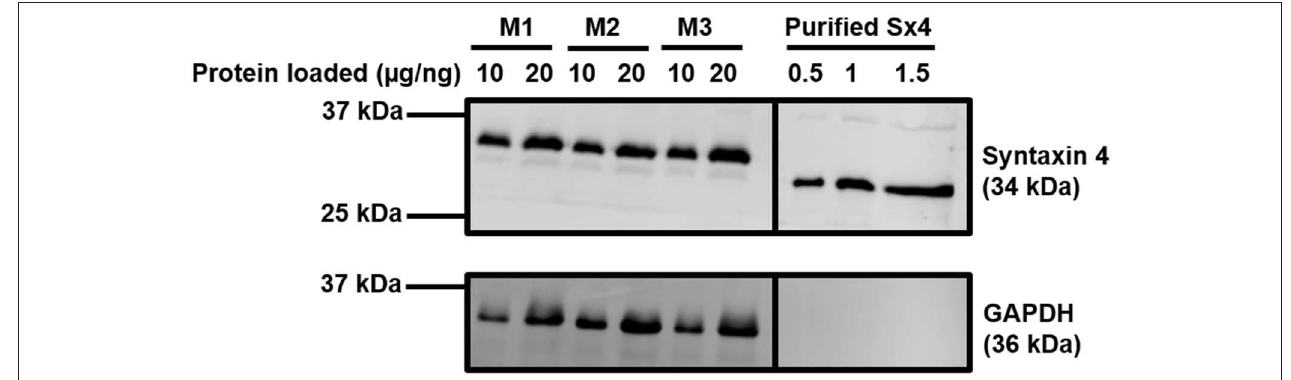
FIGURE 1 | Quantification of Syntaxin 4 expression in the heart. Protein lysates were generated from 20-week old male mouse cardiac tissue and subjected to SDS-PAGE and immunoblotting alongside purified recombinant Sx4. Lysates were incubated with antibodies probing for the expression of Syntaxin 4 and GAPDH (loading control) as shown. Protein loaded refers to 10 or 20 µ g of protein for the M1-M3 mouse cardiomyocyte samples or 0.5–1.5 ng of purified Syntaxin 4 protein (lacking the transmembrane domain and thus migrating faster than endogenous, full length Syntaxin4), as indicated. M1-3 indicates biologically independent mouse cardiac samples, where each sample is composed of lysate generated from 2 to 3 individual hearts. The approximate positions of molecular weight markers are indicated. Borders indicate where images have been cropped for presentation purposes only. Data from a representative immunoblot is shown, quantified in Table 1 .